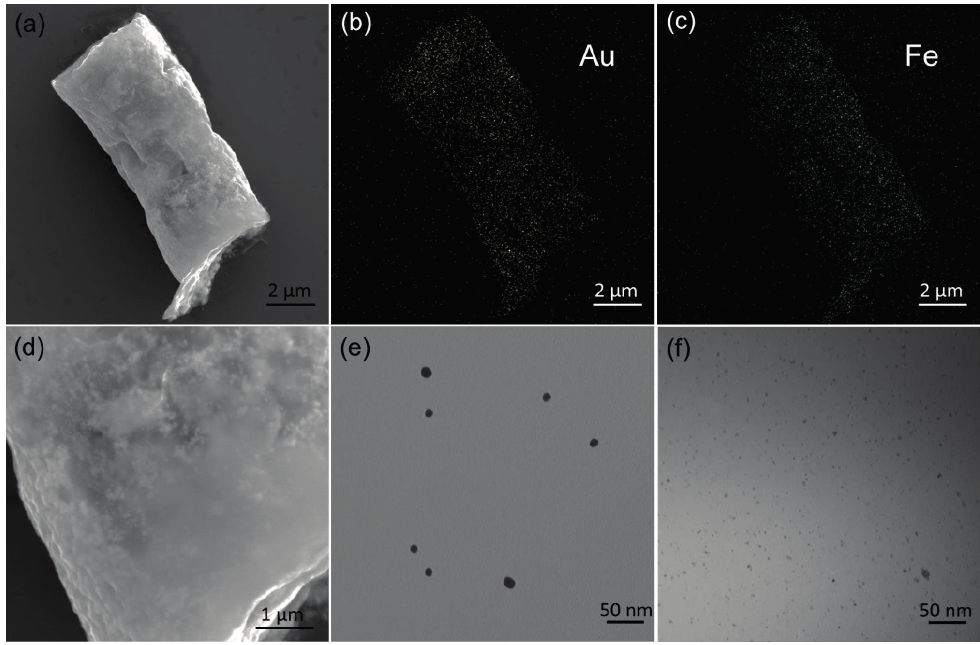
Figure 2. The characterization of the micro-tube. ( a ) SEM image of a single micro-tube; ( b ) The corresponding energy-dispersive X-ray (EDX) mapping images of ( a ) for Au distribution; ( c ) The corresponding EDX mapping images of ( a ) for Fe distribution; ( d ) Enlarged SEM image of the micro-tube; ( e ) TEM images of Fe images of Au